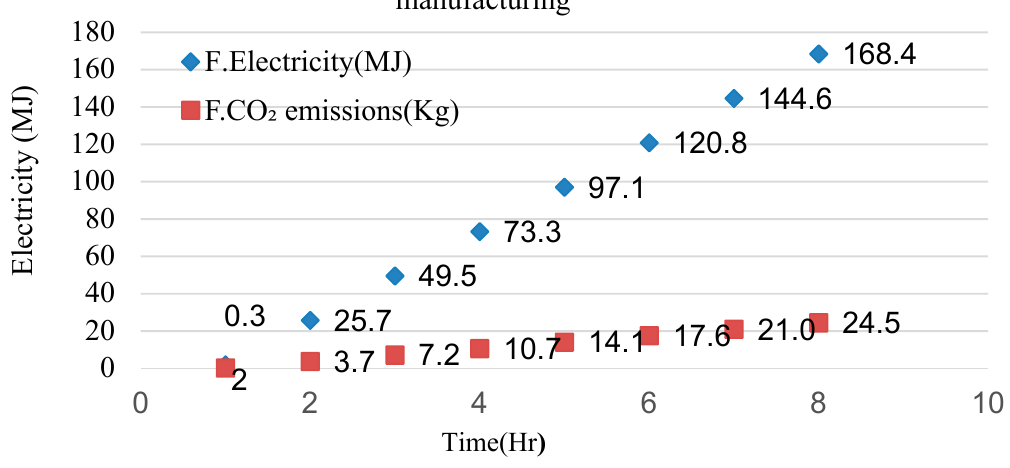
Figure 7. Daily energy consumption and CO 2 e of triaxial glass fibre fabric in the targeted manufacturing process.